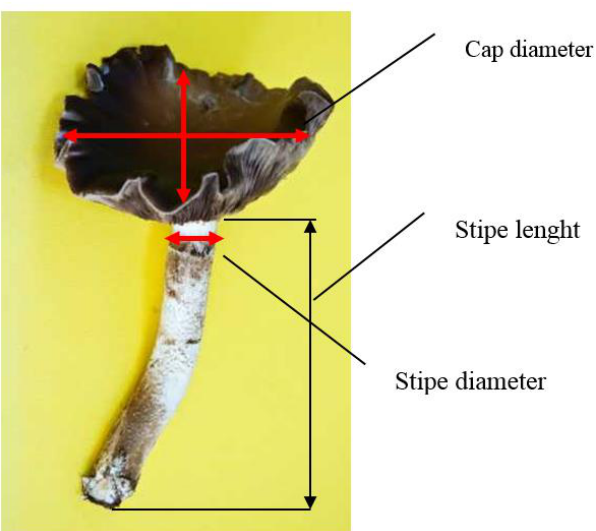
Figure 1. Diagram of biometric morphological features of A. cylindracea fruiting